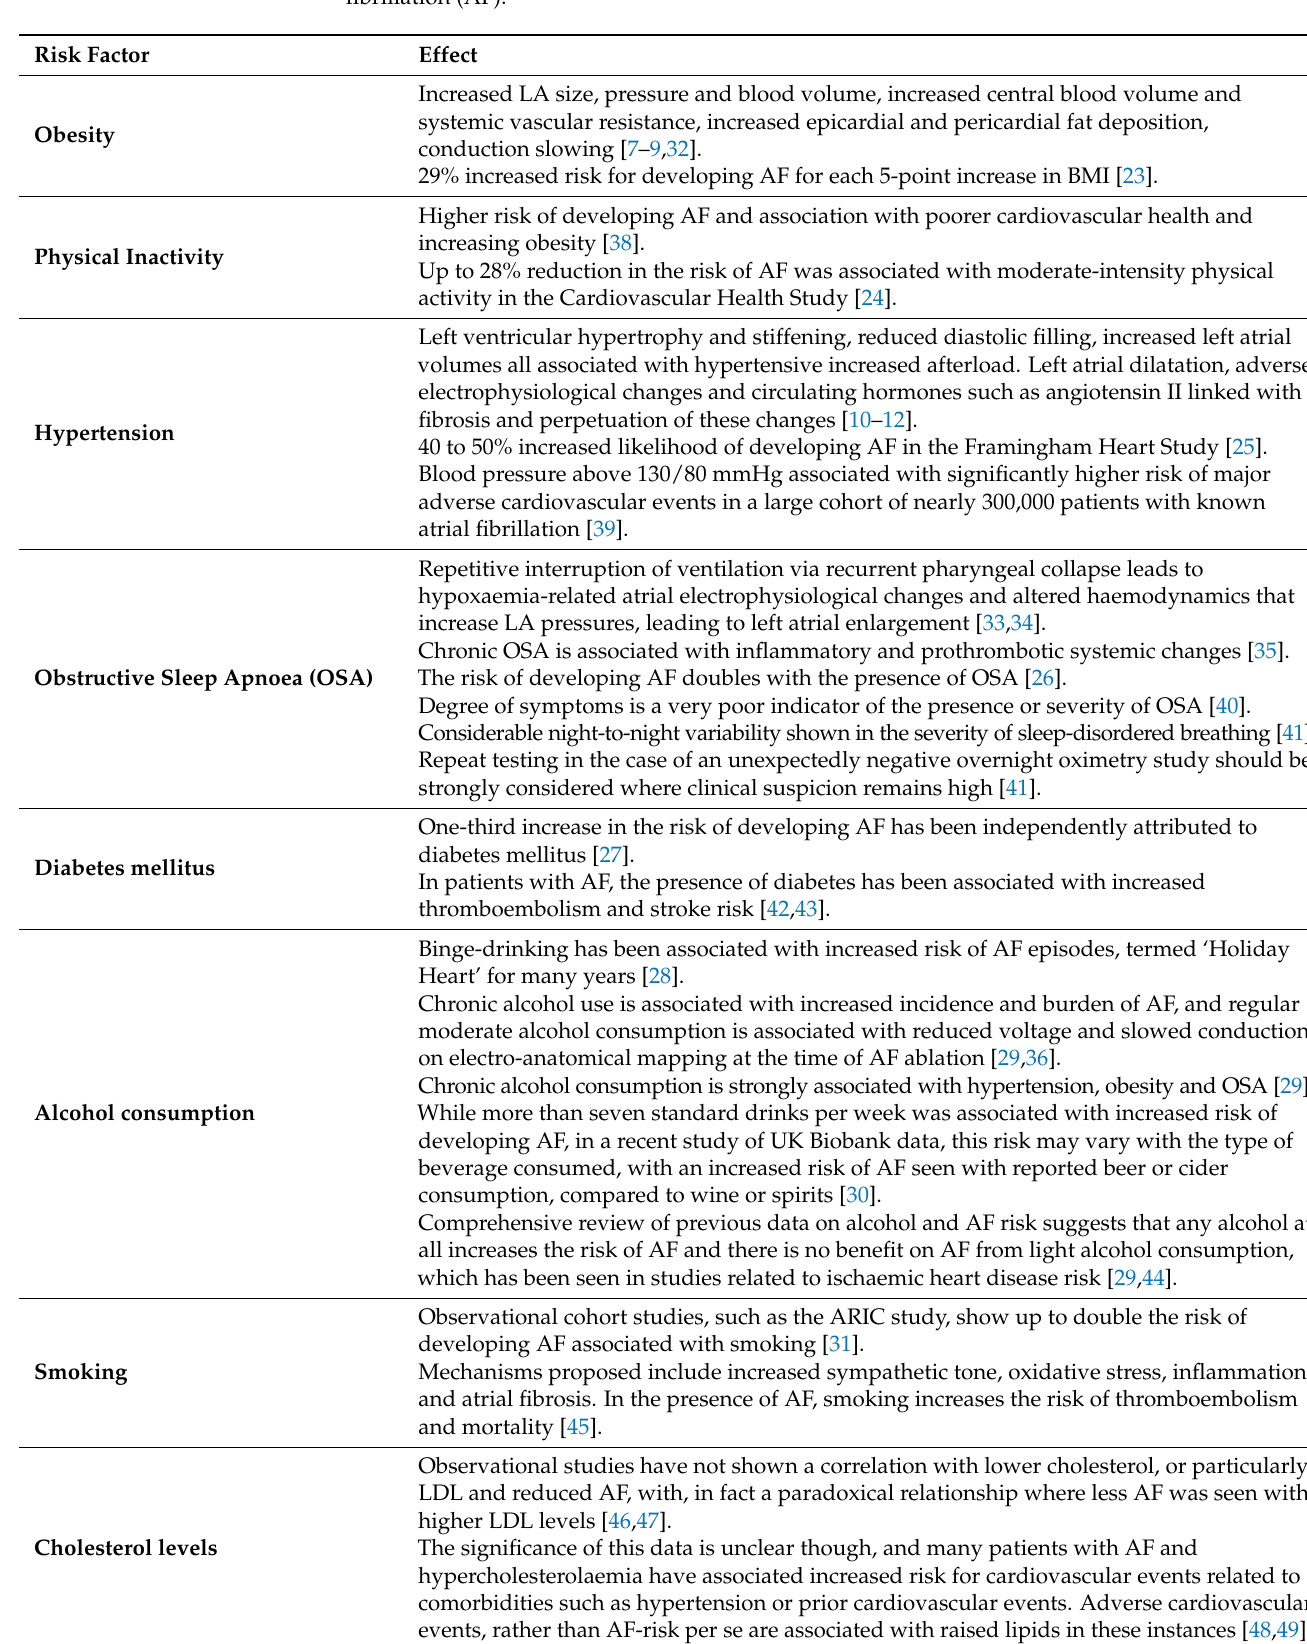
Table 1. Outline of studies which demonstrate the effects of individual risk factors on atrial fibrillation